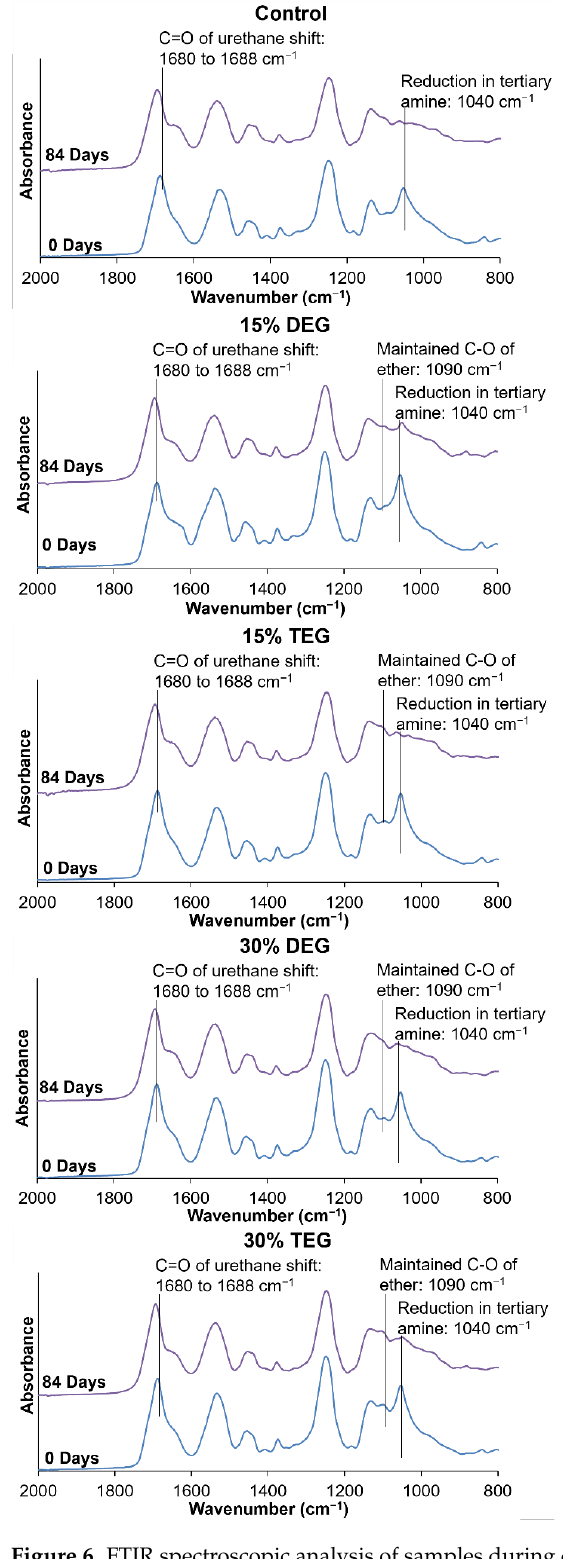
Figure 6. FTIR spectroscopic analysis of samples during degradation in oxidative media, 3% H 2 O 2 at 0 days (blue lines) and 84 days (purple lines).